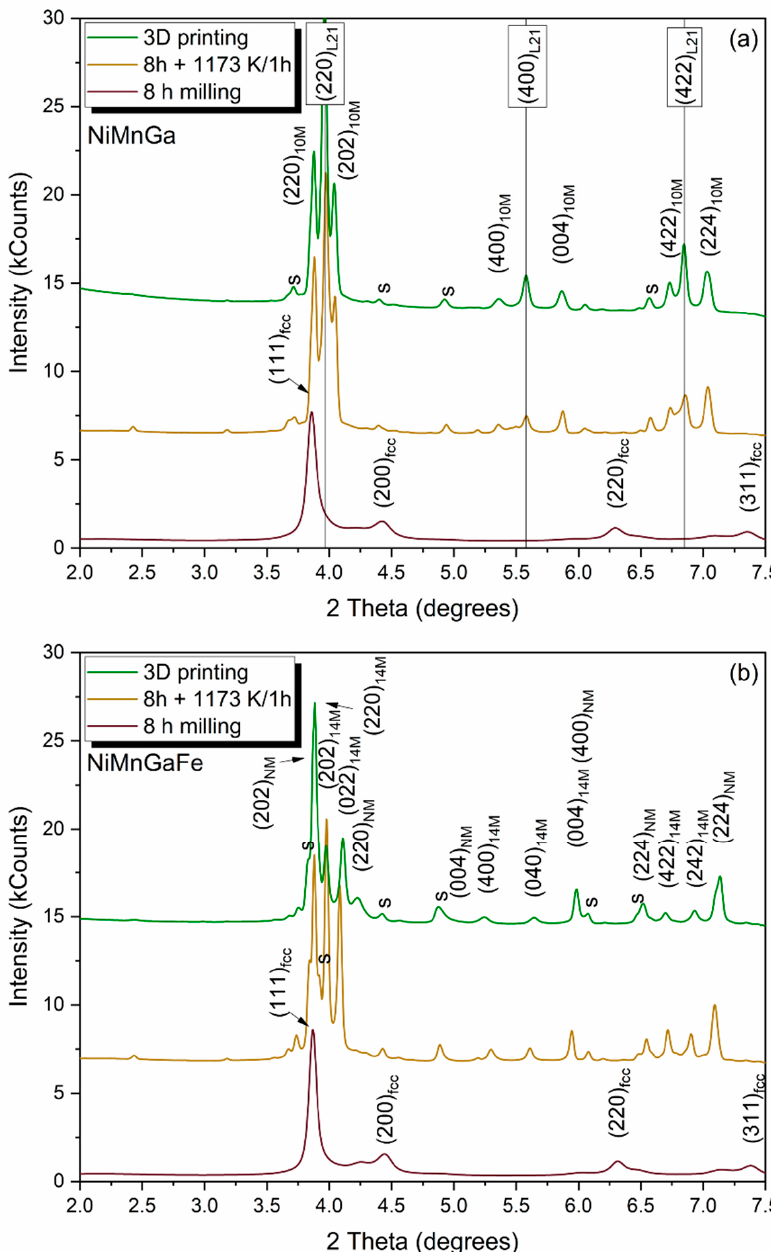
Figure 4. High energy synchrotron radiation diffraction patterns for as milled, milled and annealed and as printed Ni-Mn-Ga ( a ) and Ni-Mn-Ga-Fe ( b ) powders. The symbol “s” denotes satellite reflections related to modulations in martensite.